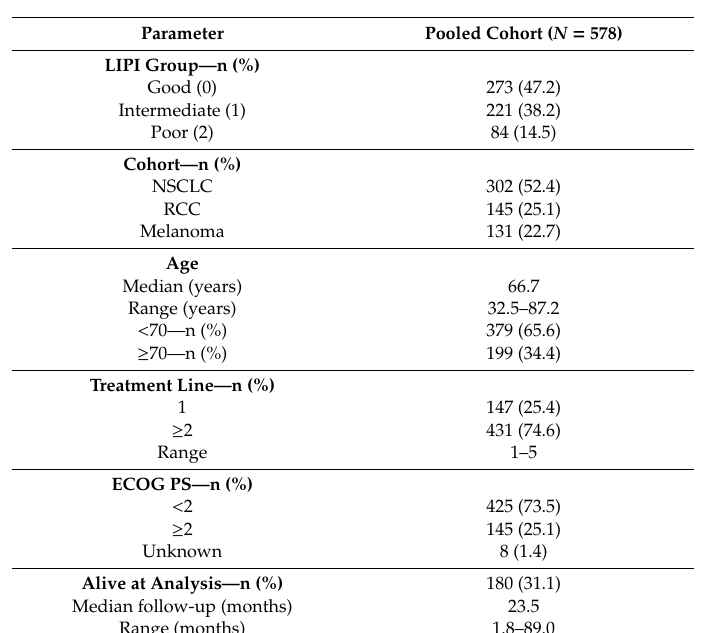
Table 1. Baseline clinical and demographic information of the pooled